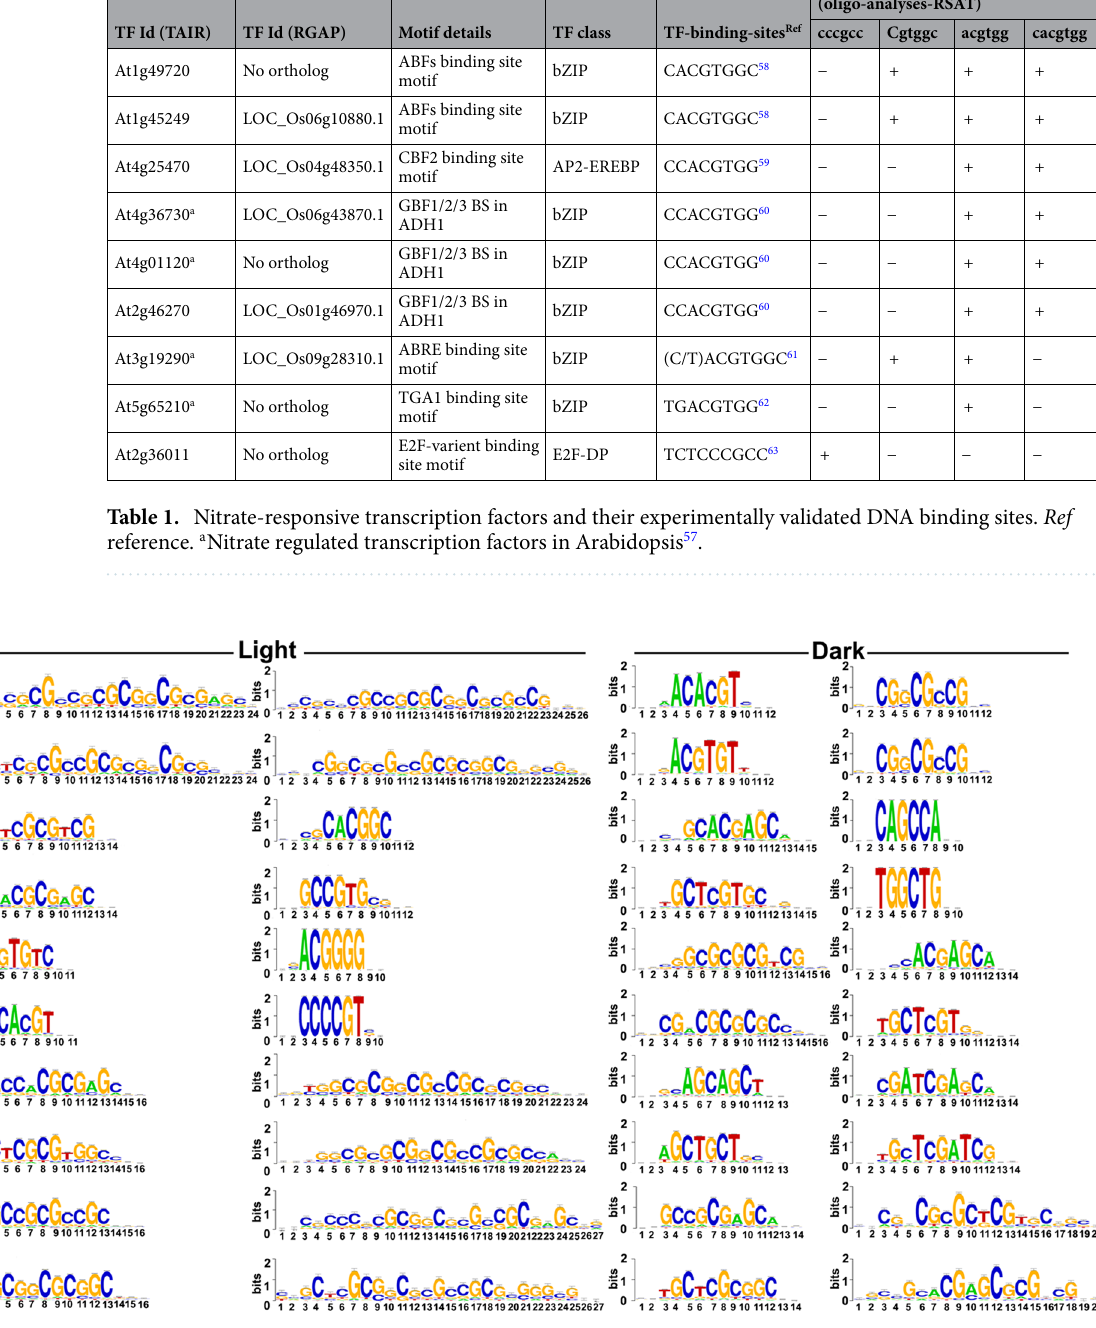
Figure 7. Prediction of over-represented cis-regulatory motifs in the promoter of nitrate-responsive genes. Significant enrichment of nitrate-responsive motifs in the promoter region of DEGs was identified using RSAT plantstool (https ://rsat.eead.csic.es/plant